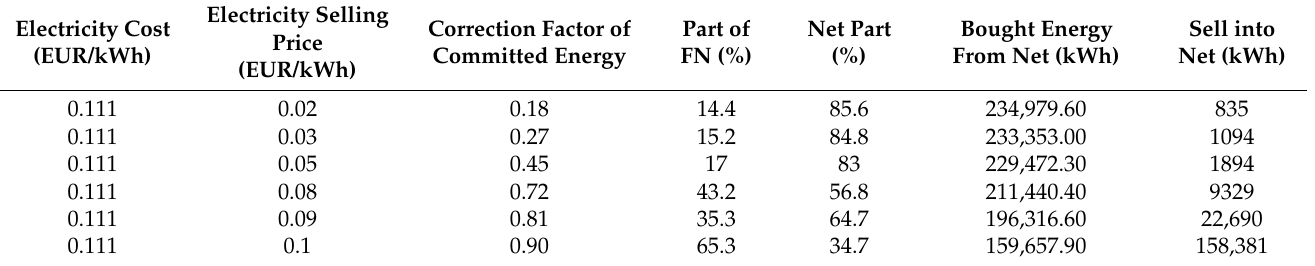
Table 9. Sensitivity analysis according to purchase price.